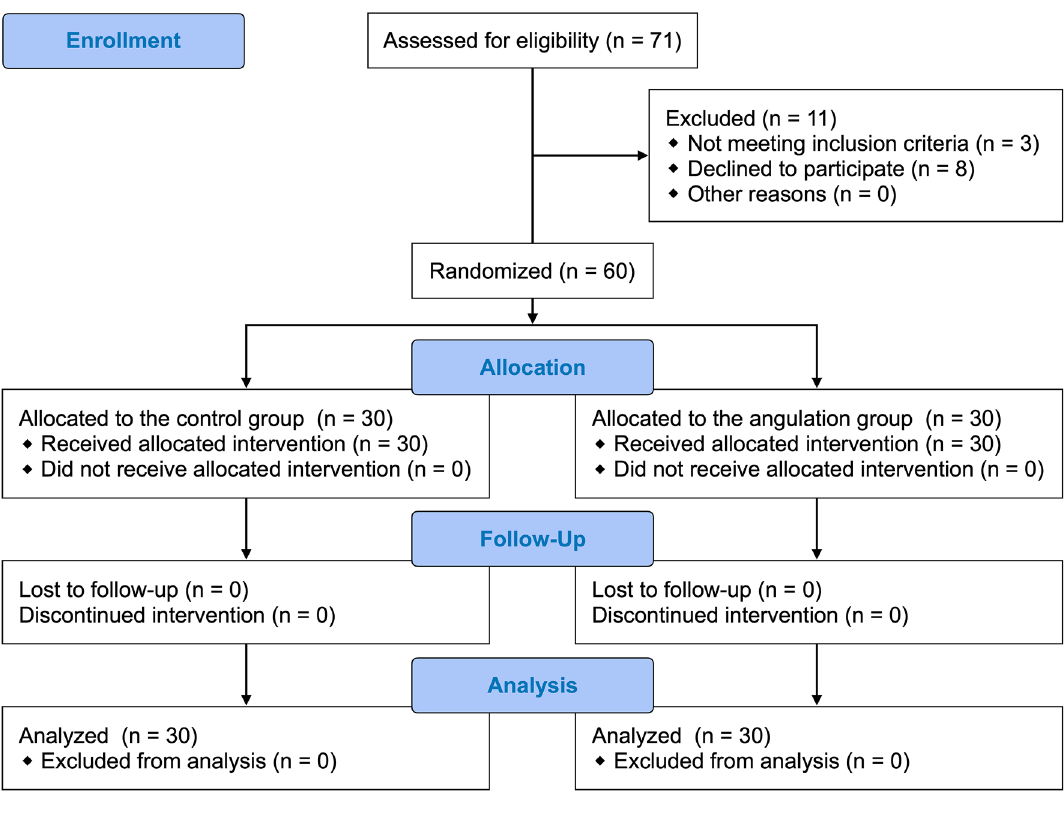
Figure 3. CONSORT study flow diagram.